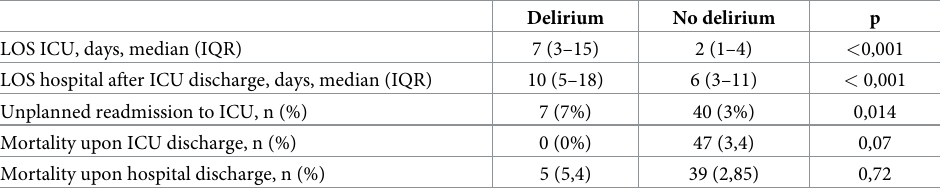
Table 2. Short-term outcomes.